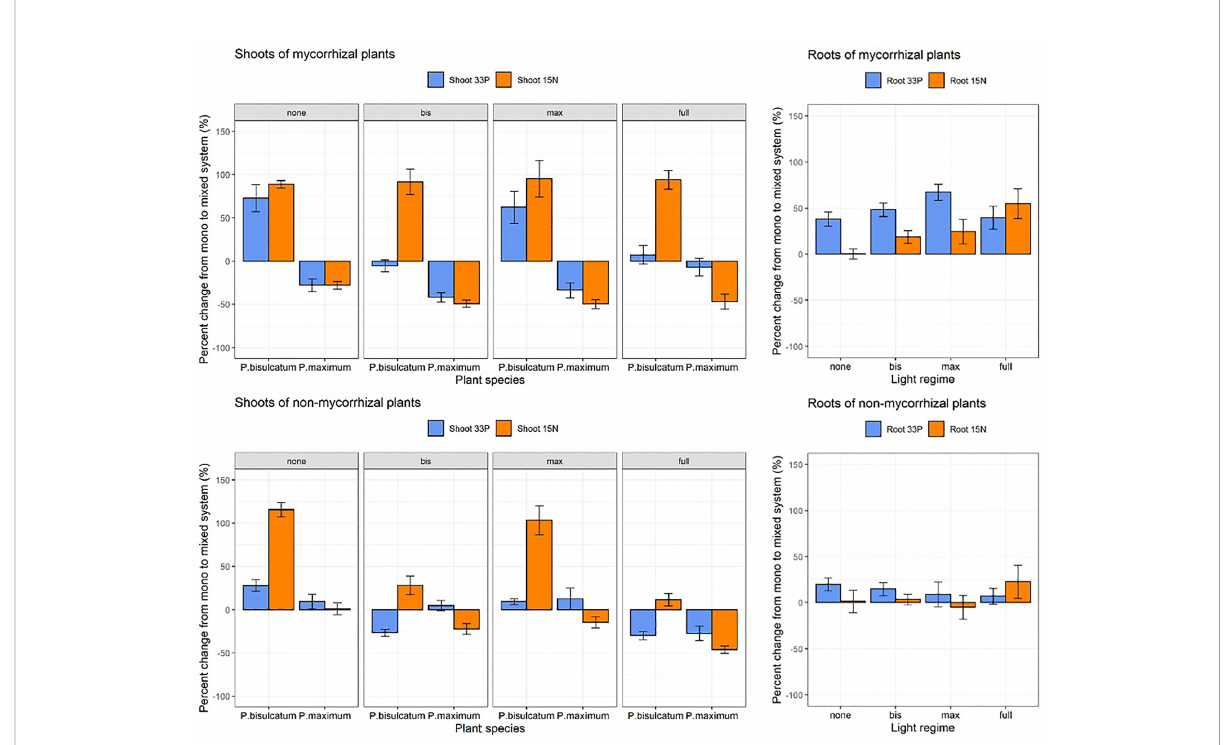
FIGURE 4 The effects of light regime, mycorrhizal status, and plant species on shoot 33 P-, shoot 15 N, root 33 P and root 15 N responses in mixed system compared to mono system. Light regime: none (no shading), full (both plants are shaded), bis ( P.bisulcatum is shaded) and max ( P.maximum is shaded). Mycorrhizal status: mycorrhizal (R.irregularis) and non-mycorrhizal